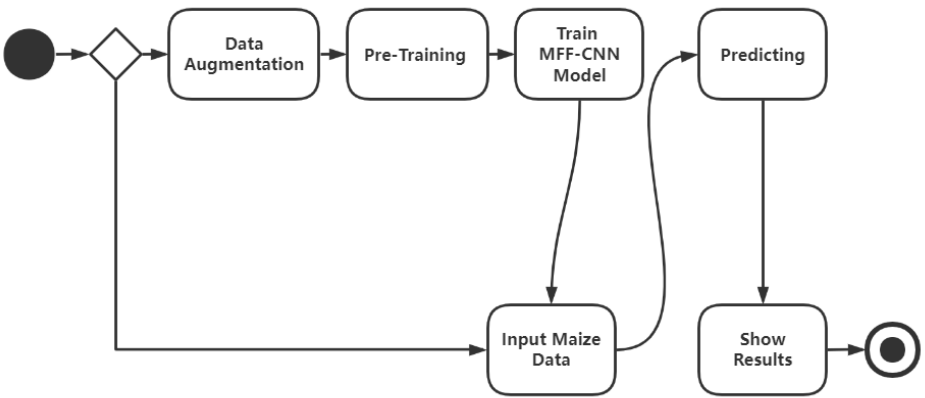
Figure 4. Activity diagram of the proposed network.